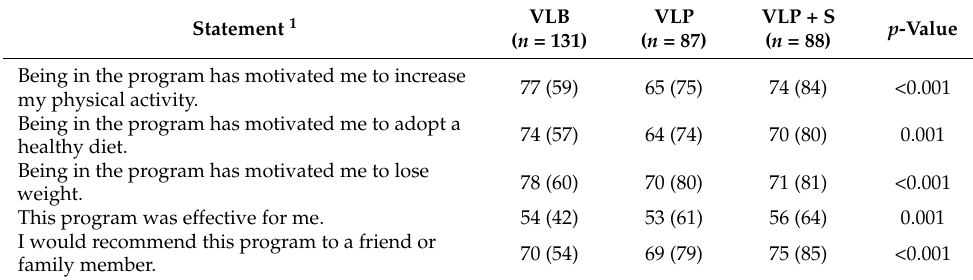
Table 5. Vibrant Lives program satisfaction by intervention